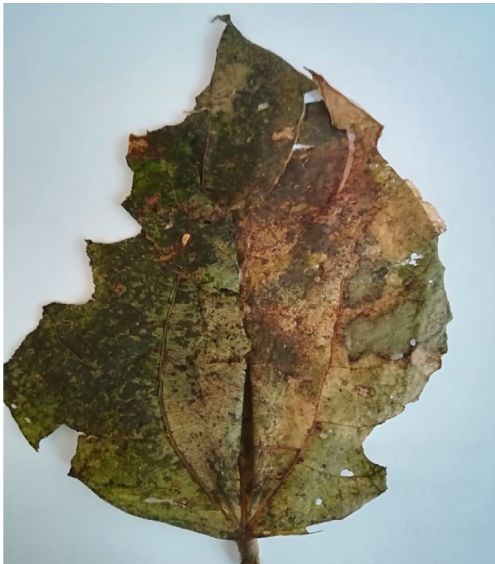
Figure 3: Lablab diseased leaf photograph during field